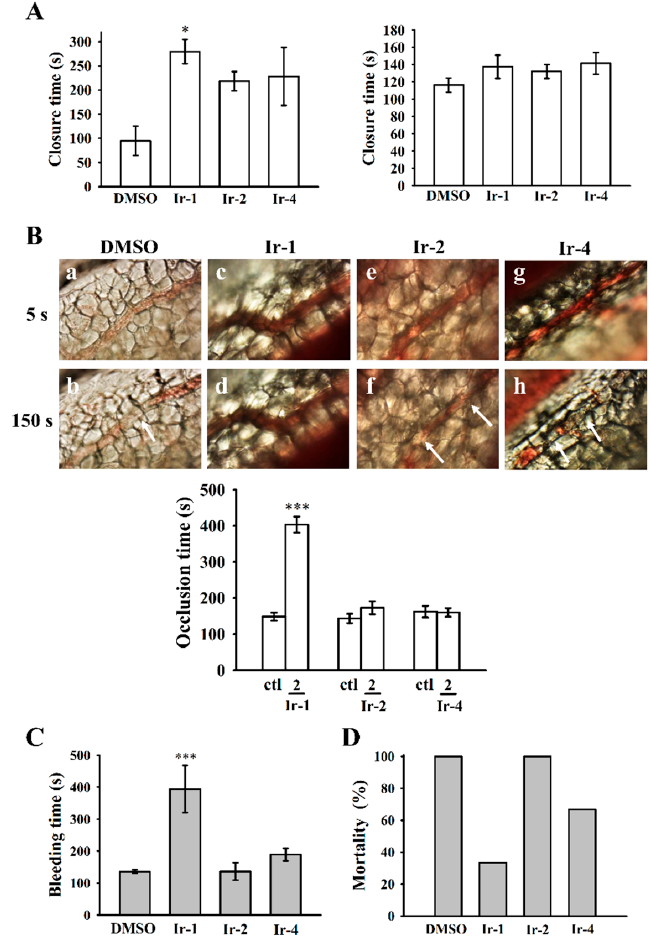
Figure 7. Effects of iridium complex on PFA-100 closure time and thrombotic platelet plug formation in the mesenteric venules, bleeding time and ADP induced pulmonary thrombosis in mice. ( A ) Shear-